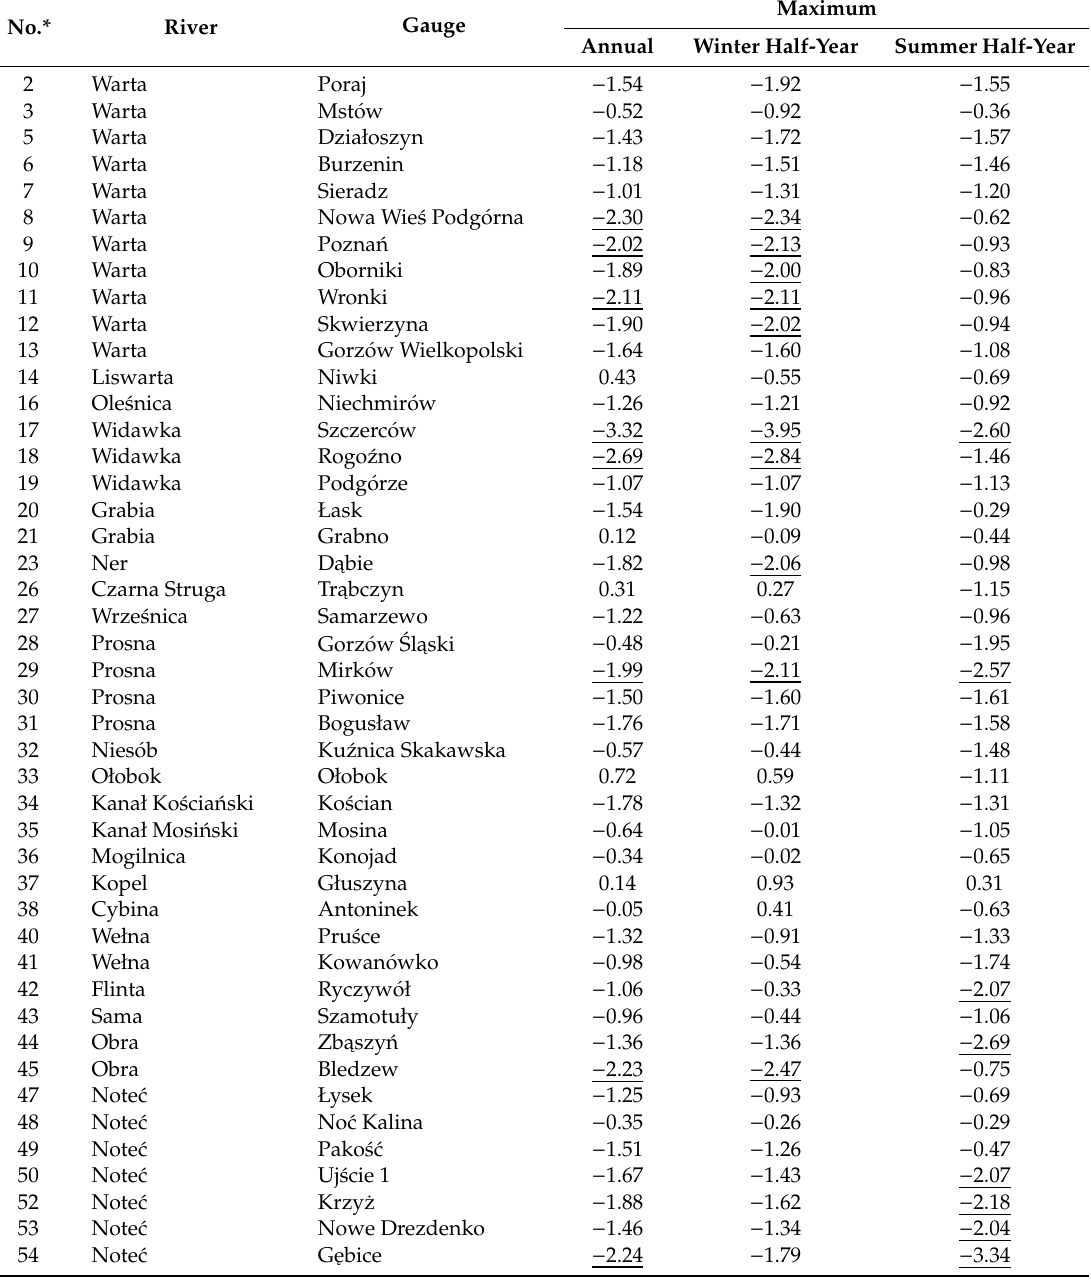
Table A1. Results of the Mann–Kendall (M-K) test Z